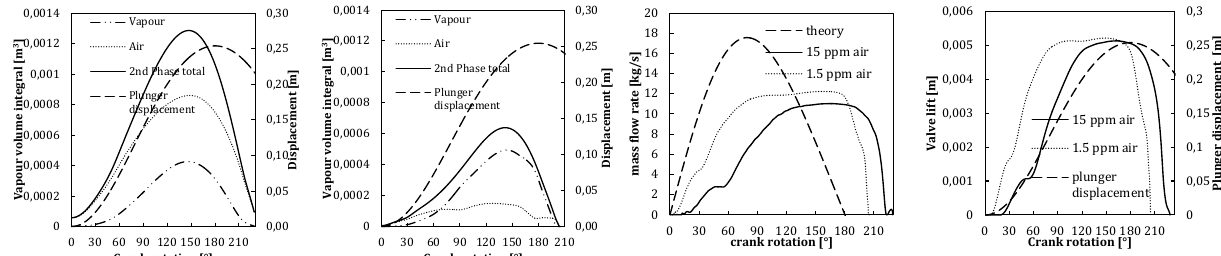
Figure 10. (left) mass flow rate throughout the inlet stroke when the air mass fraction is 15 and 1.5 Figure 10: (left) mass flow rate throughout the inlet stroke when the ppm. (right) valve lift history. air mass fraction is 15 and 1.5 ppm; (right) valve lift history. and right). The case of 1.5 ppm of air mass fraction shows a slightly higher vapour volume integral (0.49 l versus 0.42 l) and a much lower air volume integral (0.15 l against 0.49 l of Figure 11 . Case 1 (15 ppm air mass fraction) at 120° of crank rotation . (left) total second phase volume fraction. (middle) air volume fraction. (right) vapour volume fraction.